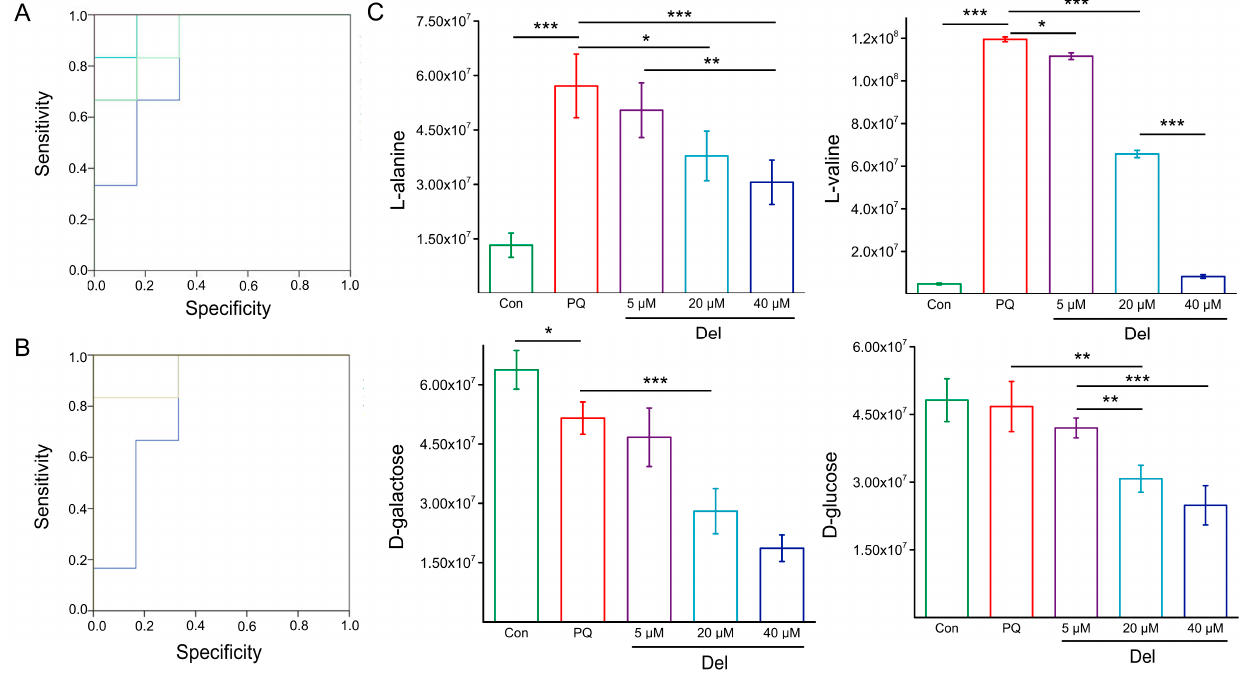
Figure 5. Prediction and validation of biomarker metabolites. ( A ) Predicted ROC curves of biomarker metabolites in PQ treated group. ( B ) Predicted ROC curves of biomarker metabolites in Del pre-protected group. ( C ) Effects of Del pre-protection on the levels of the four metabolic biomarkers. * means p < 0.05, ** means p < 0.01, and *** means p < 0.001. Table 2. List of the screened biomarker metabolites.